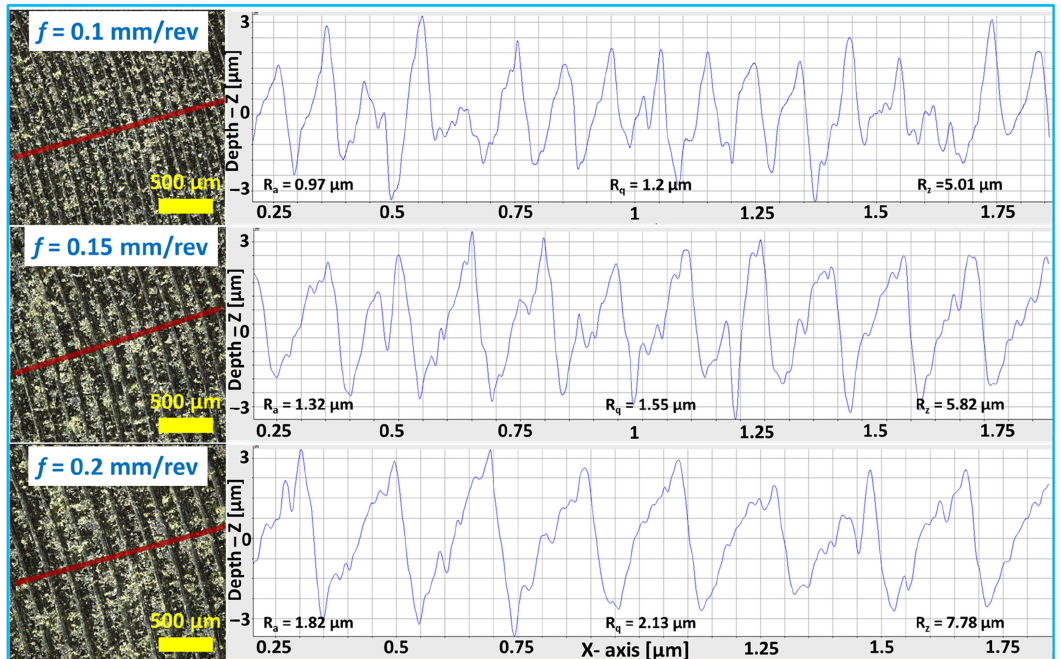
Figure 15. The edge roughness profilograms analyzed for the bottom section i.e., side 2 of the ZnO ceramic for different feed rates during turning. Processes 2021 , 9 , x FOR PEER REVIEW